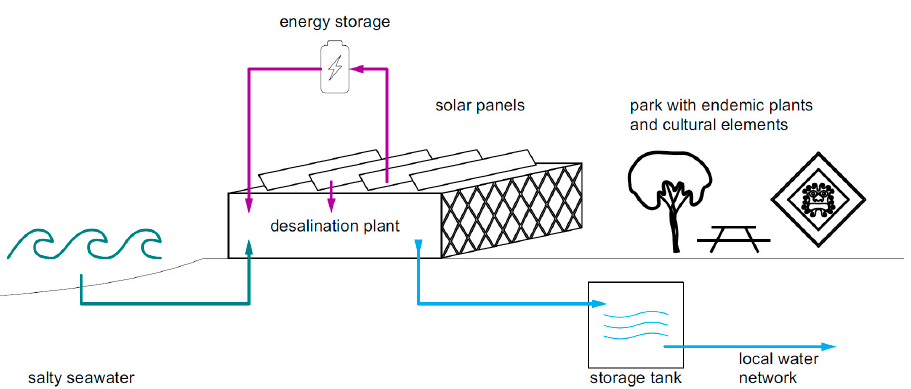
Figure 8. Integration of desalination plant and cultural park. Source: author .